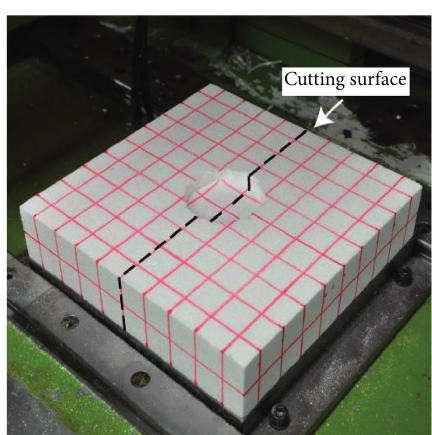
Figure 9: Location of cutting the expanded